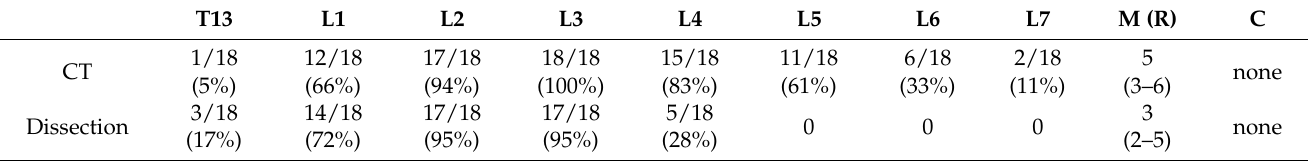
Table 1. The spreading of a 50:50 iohexol/methylene blue mixture after application of the quadratus lumborum block (QLB) in nine canine carcasses bilaterally (18 injections). These results are based upon CT images and dissection and are shown as number (n/n) and percentage (%). The CT images assessed spreading around the vertebral bodies, while dissection assessed the number of stained ventral branches of the spinal nerves. M (median) represents the spreading of the mixture and R (range) shows the minimum and maximum spread observed. C (complications) shows the complications found with both methods of